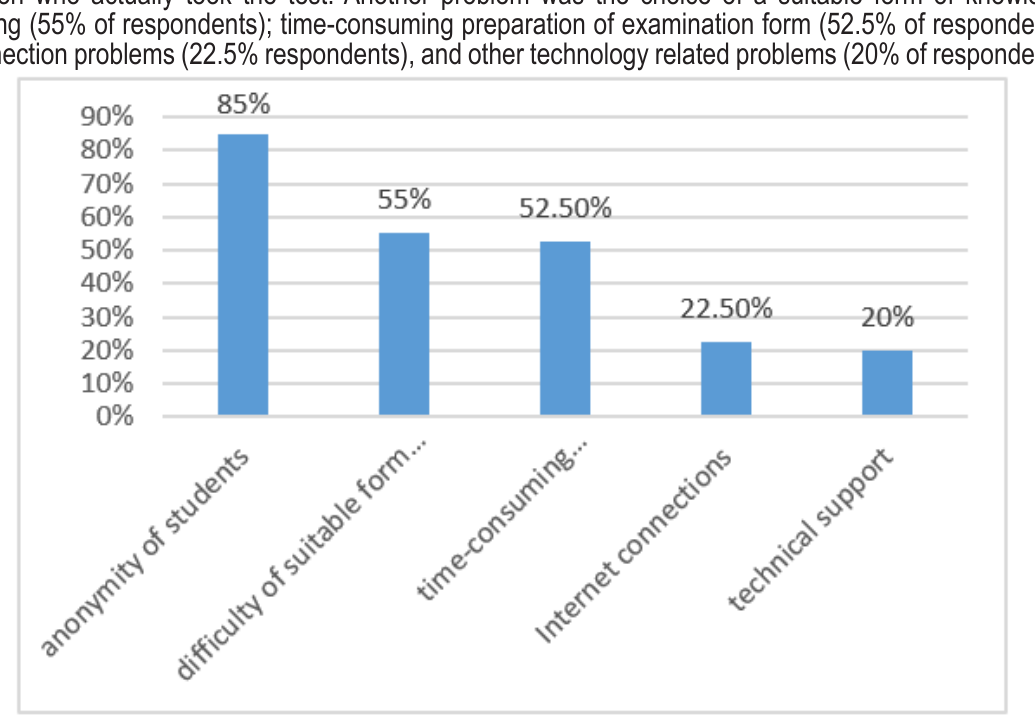
Figure 8. Limitations of the assessment process during the online education from the teachers’